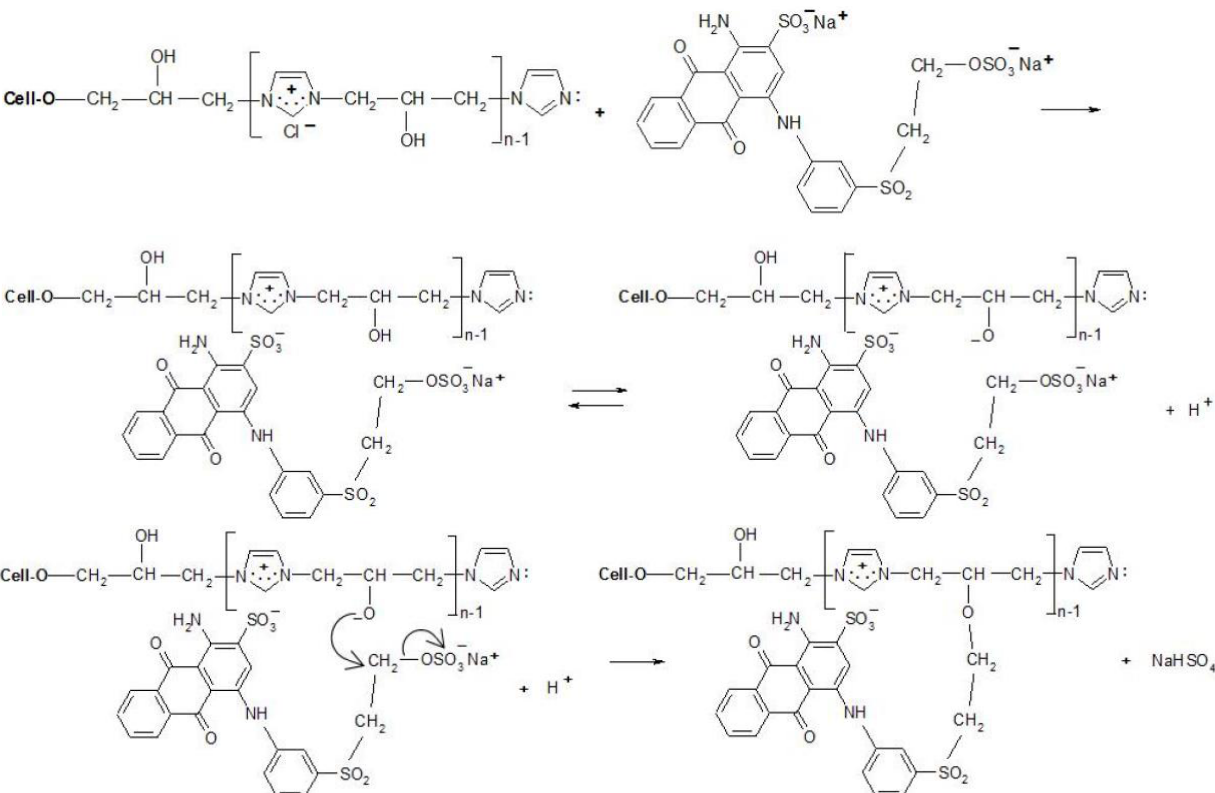
Figure 10. Proposed mechanism of dyeing [Cell-O-IME] + Cl ‒ with RB 19 (mono-VS reactive dye).